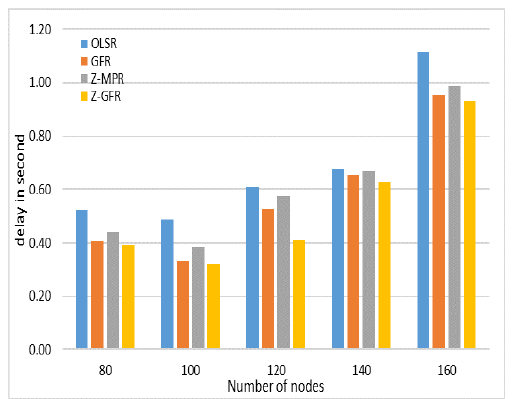
Figure 21. Delay of the udp